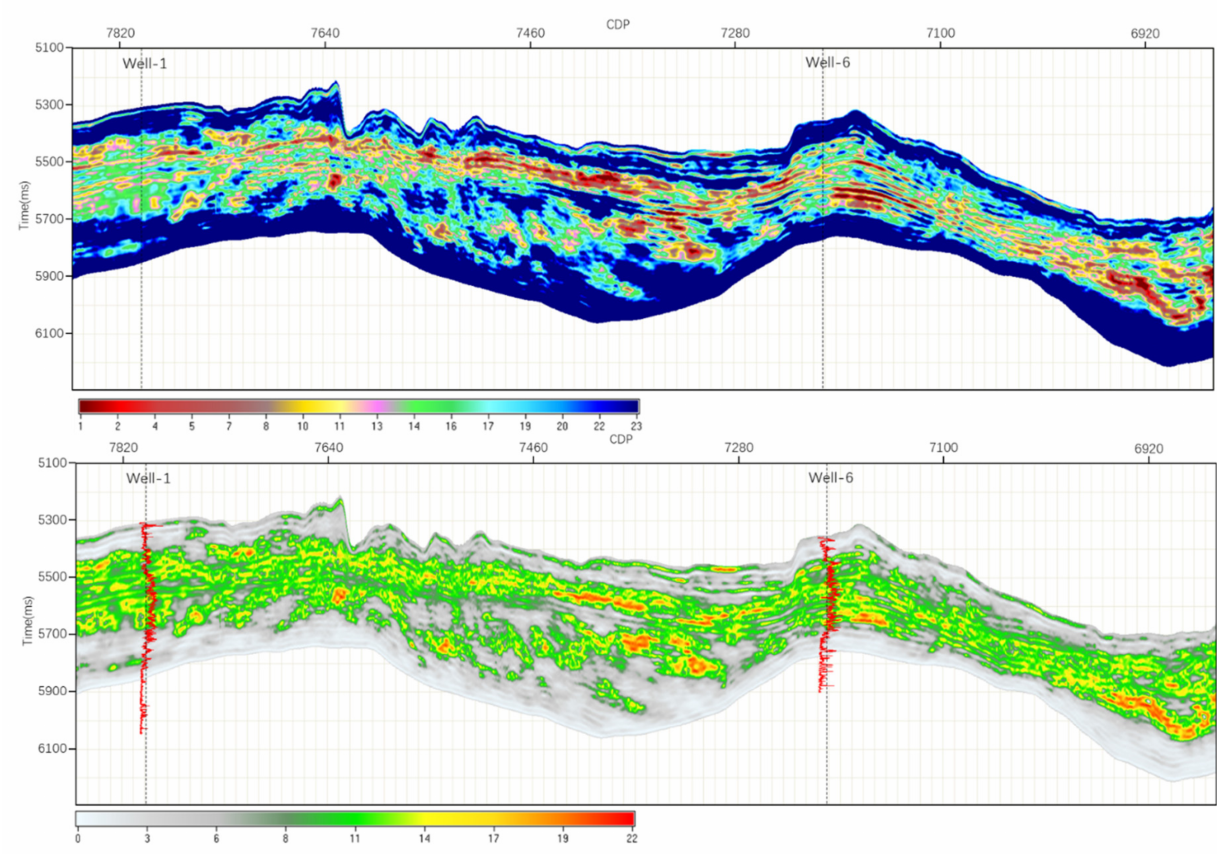
Figure 13. Comparing the Lame coefficient profile calculated by inversion with the porosity profile calculated by inversion, Well 6 is a new well with porosity information that can be used to verify the inversion